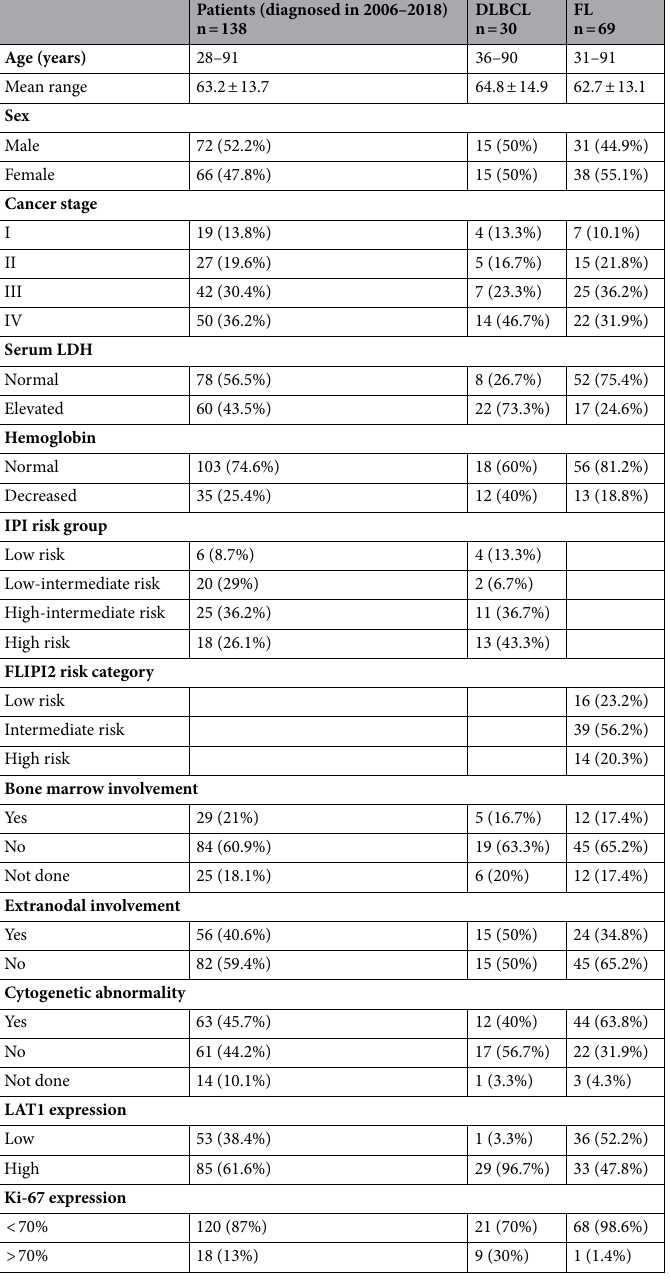
Table 1. Characteristics at diagnosis of patients with